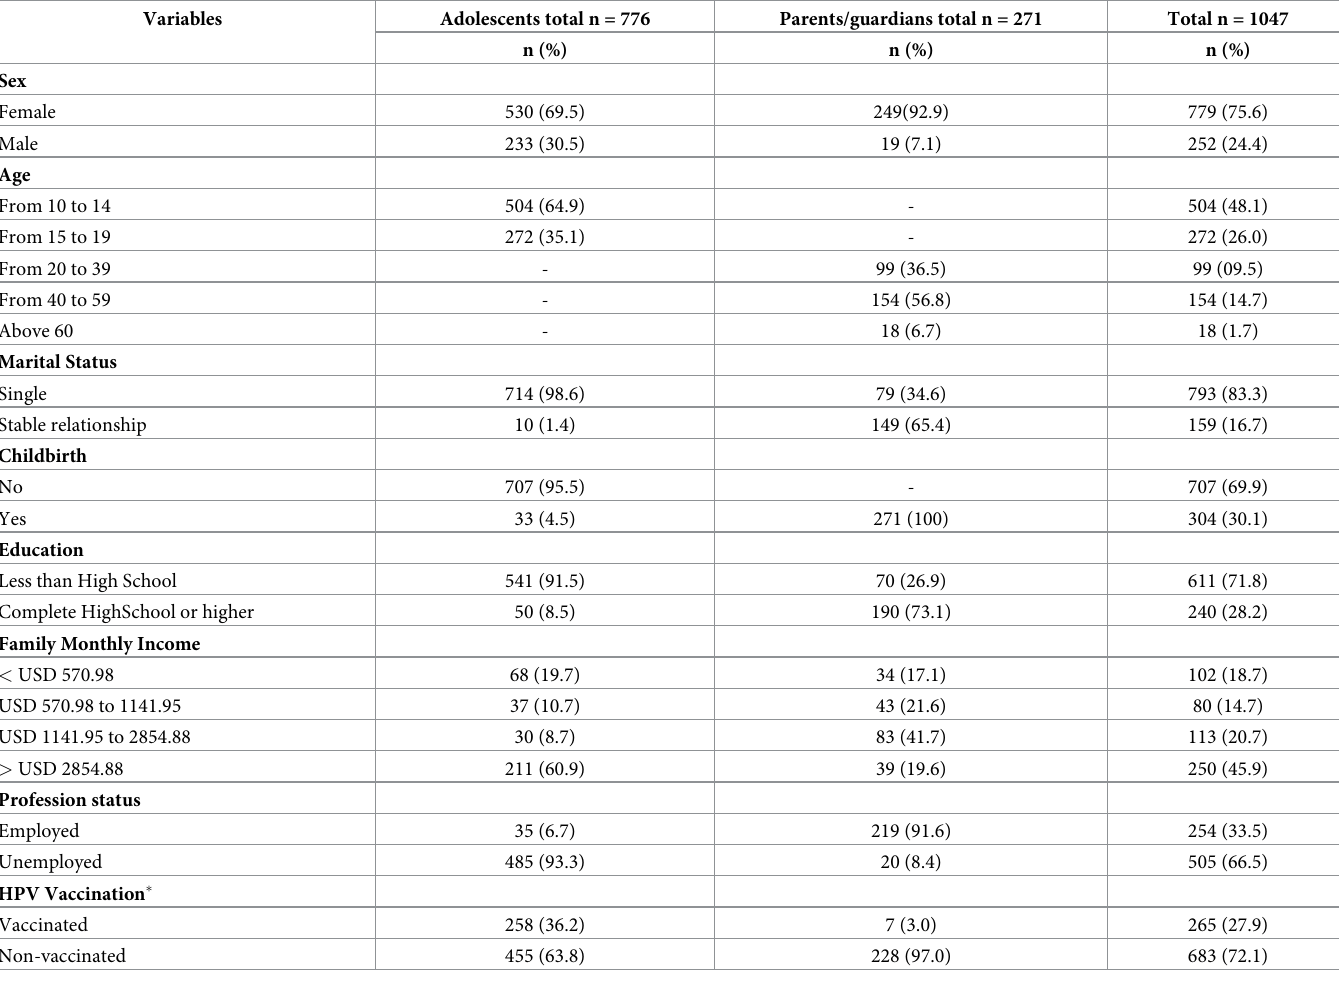
Table 1. Sociodemographic characteristics of adolescents and parents/guardians interviewed during the implementation of the HPV vaccine in 2015. Sao Paulo, Brazil, 2015.